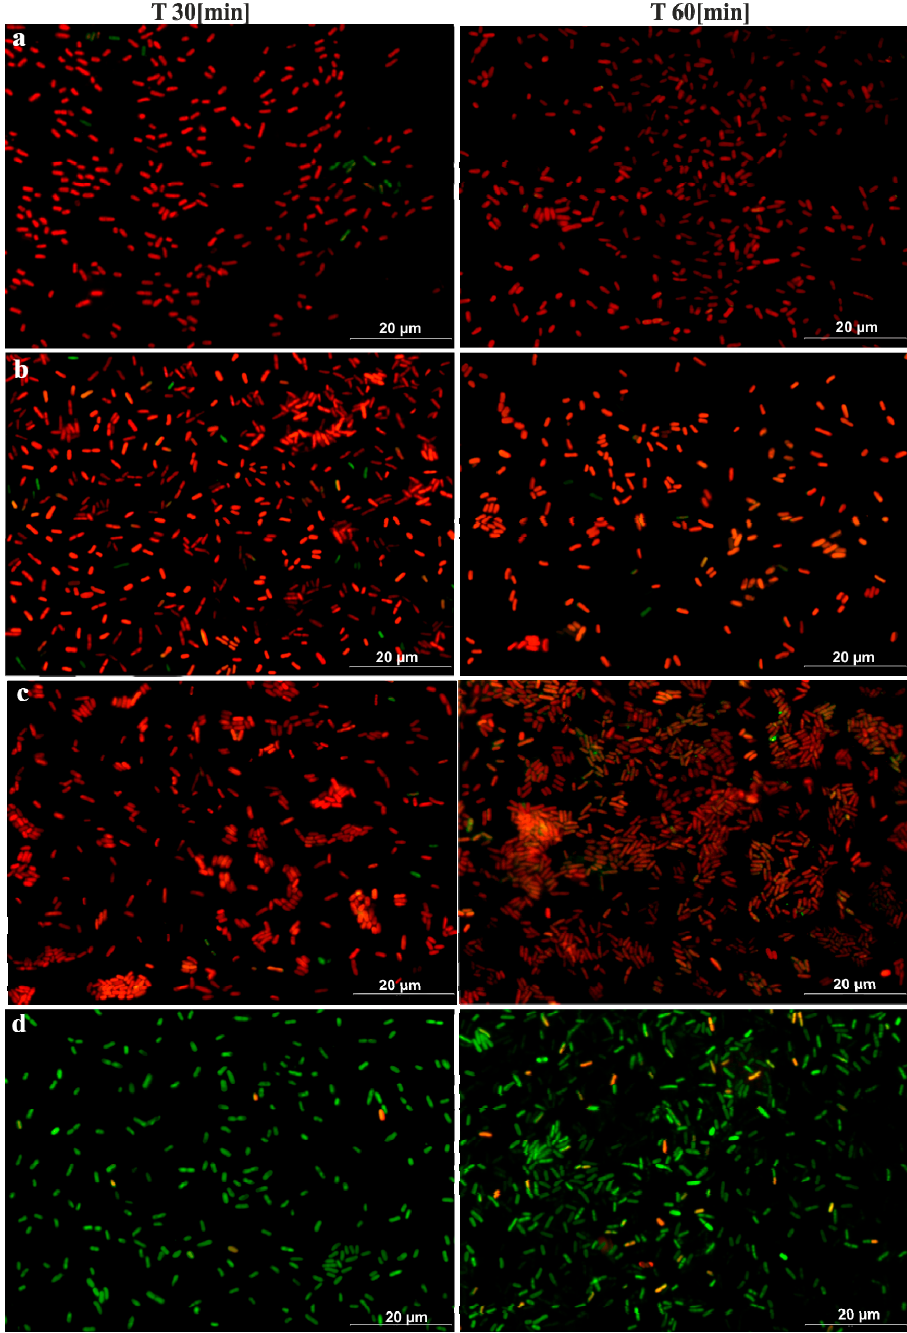
Figure 5. Photographs showing the survival rate of E. coli in selected time periods on: Cu ‐ ETP ( a ), CuZn37 ( b ), CuZn6 ( c ), and stainless steel ( d ).